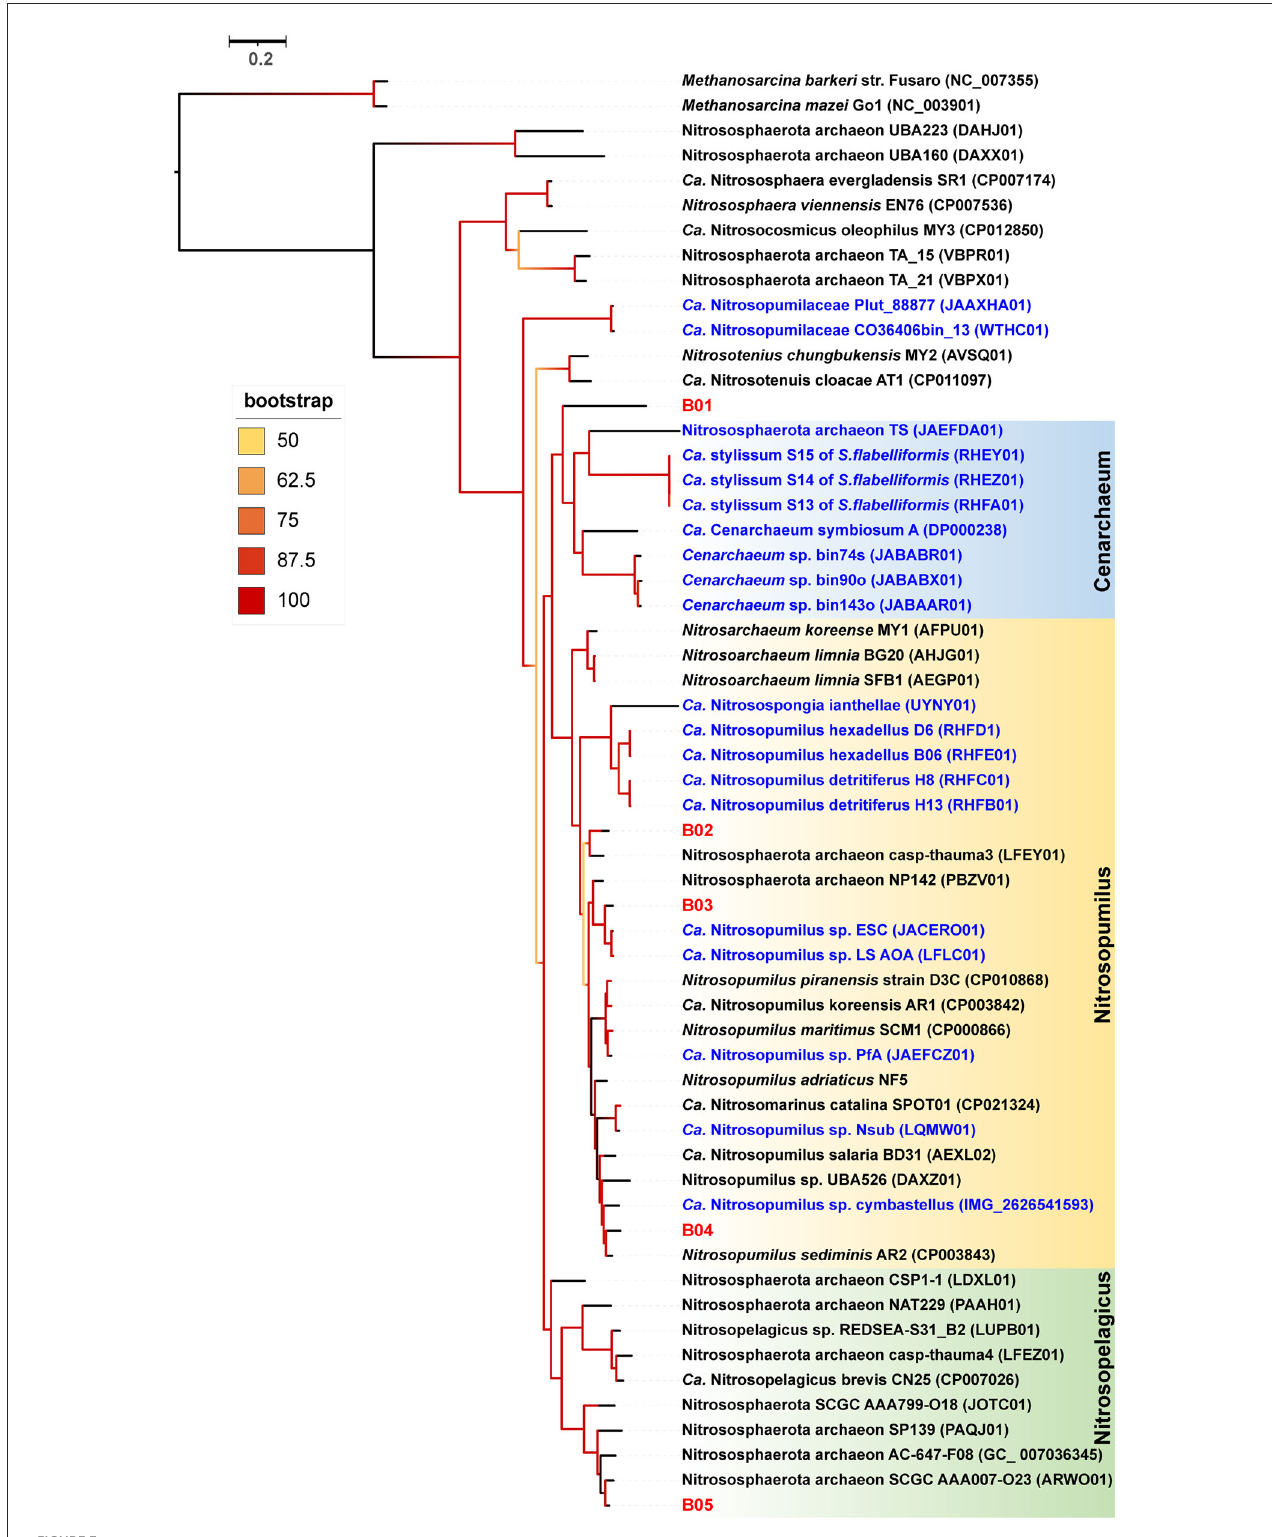
FIGURE3 Phylogenomic tree of the sponge-associated AOA MAGs. The phylogenomic maximum-likelihood tree of sponge-associated AOA MAGs was constructed using the “LG + F + R7” model. Bathydorus sp. SQW35 sponge-associated MAGs are marked with red. Sponge-associated reference MAGs from other environments are marked with blue. Methanosarcina barkeri and Methanosarcina mazei Go1 (p_Euryarchaeota) are used as outgroups. All the reference genomes are listed in Supplementary Table